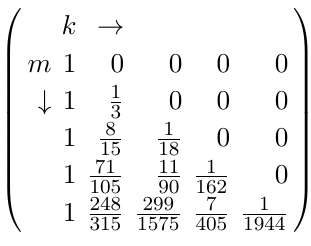
Table 2 . Some values of C ( m, k )